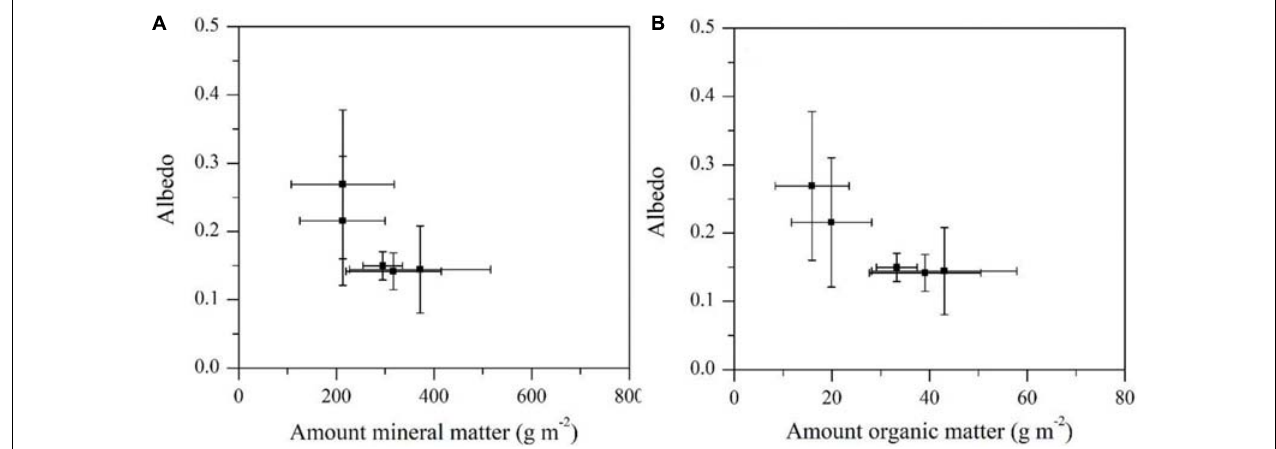
FIGURE 8 | Relationships between surface albedo and the number of mineral particles (A) and surface albedo and the amount of organic matter (B) on the ice surfaces.